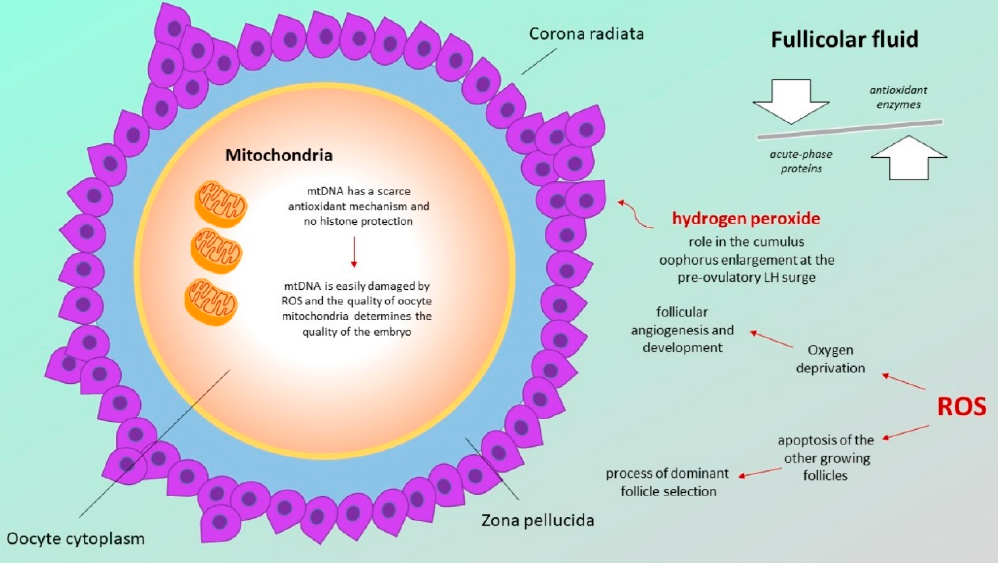
Figure 1. Pathway of the different actors involved in female gonad optimal functionality.